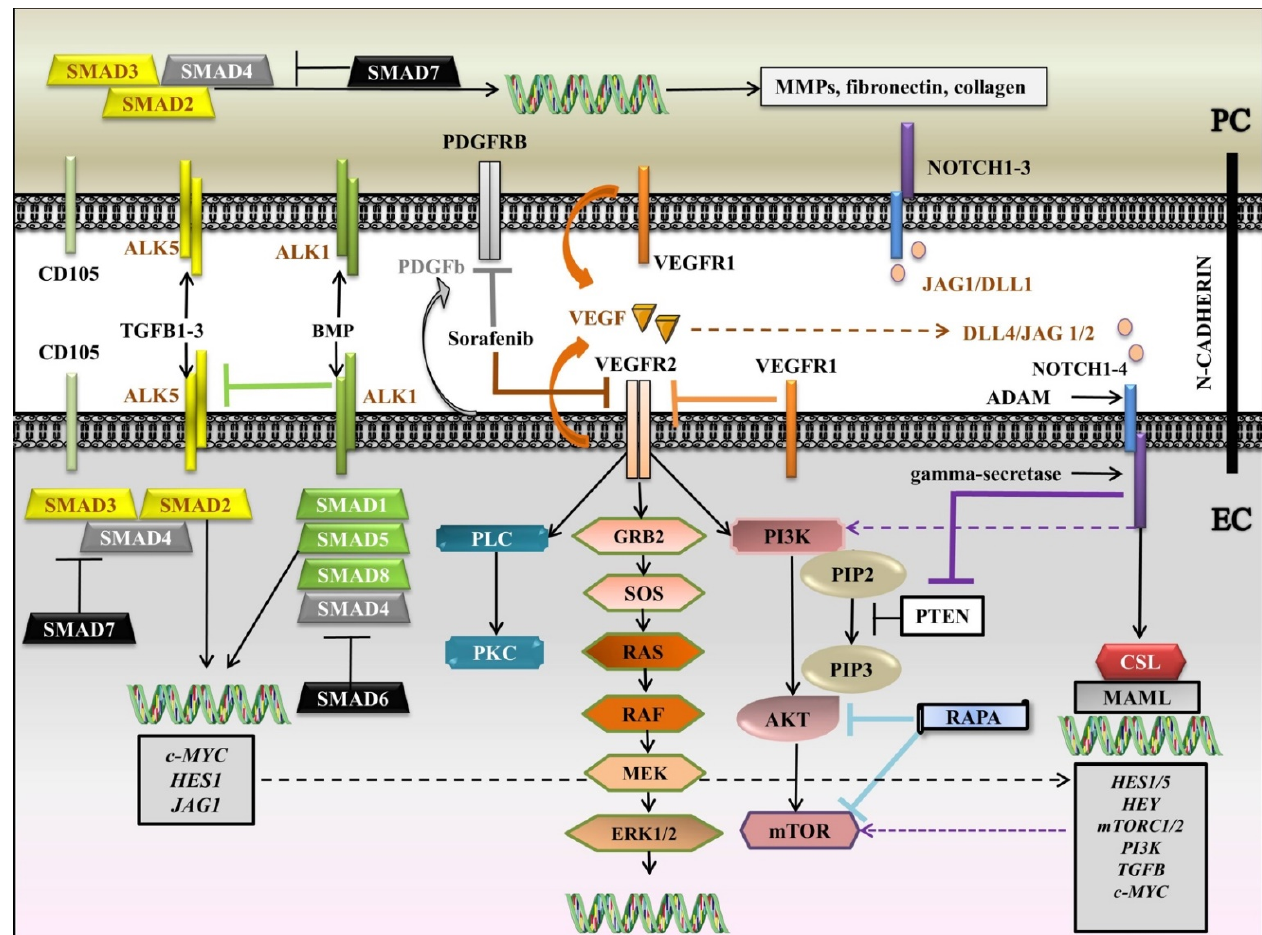
Figure 2. Diagram of the interlinking latticework among VEGF, NOTCH, PDGF, TGFB, and downstream signaling pathways. ADAM: Adisintegrin and metalloprotease; ALK: Activin-like kinase; BMP: Bone morphogenetic protein; CSL: CBF1/suppressor of hairless/LAG1; DLL: Delta-like; EC: endothelial cell; ERK1/2: Extracellular signal-regulated kinases 1/2; GRB2: Growth factor receptor-binding protein 2; JAG: Jagged; MAML: Mastermind-like; MEK: Mitogen-activated protein kinase kinase; MMPs: matrix metalloproteinases; mTKI: multi-Tyrosine Kinase Inhibitor; mTOR: mammalian target of rapamycin; NICD: Notch intracellular domain; PC: pericyte; PDGFB: Platelet-Derived Growth Factor b; PDGFRB: Platelet-Derived Growth Factor Receptor B; PI3K: Phosphatidylinositol 3-kinase; PIP2: phosphatidylinositol (4,5)-bisphosphate; PIP3: phosphatidylinositol (3,4,5)-trisphosphate; PKC: Protein kinase C; PLC: Phospholipase C gamma; RAPA: rapamycin; R- SMAD: receptor-regulated SMAD; SMAD: Small Mothers Against Decapentaplegic protein; SOS: Son of sevenless; TGFB: Transforming growth factor beta; VEGF: Vascular endothelial growth factor; black arrows: main signaling pathways; blunt-ended lines: blockade/inhibition; dashed arrows: induction/activation. Segments of the figure were sketched by using artworks from Servier Medical Art (15 November 2021). Servier Medical Art by Servier is licensed under a Creative Commons Attribution 3.0 Unported